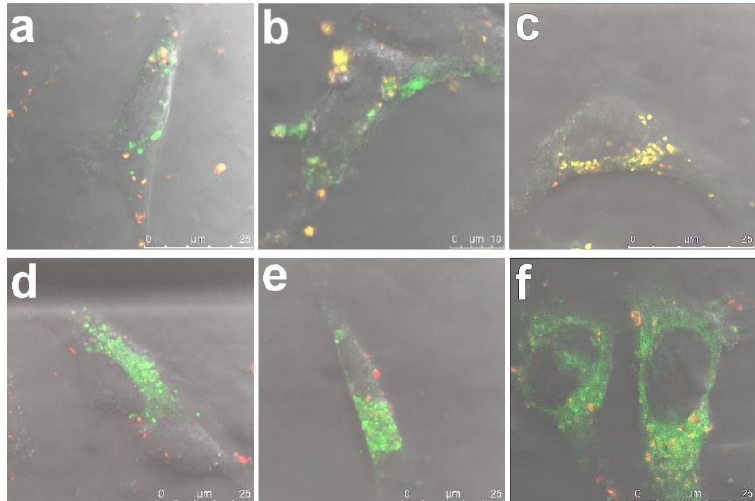
Figure 2. The temporal intracellular trafficking of PEI-MSNs with early endosomes and late endosomes: ( a – c ) Localization of PEI-MSNs (red) with GFP-tagged early endosomal antigen1 (green) at 24 h, 48 h and 72 h, respectively. ( d – f ) Localization of PEI-MSNs (red) with GFP-tagged late endosomal marker Rab7 (green) at 24 h, 48 h and 72 h,